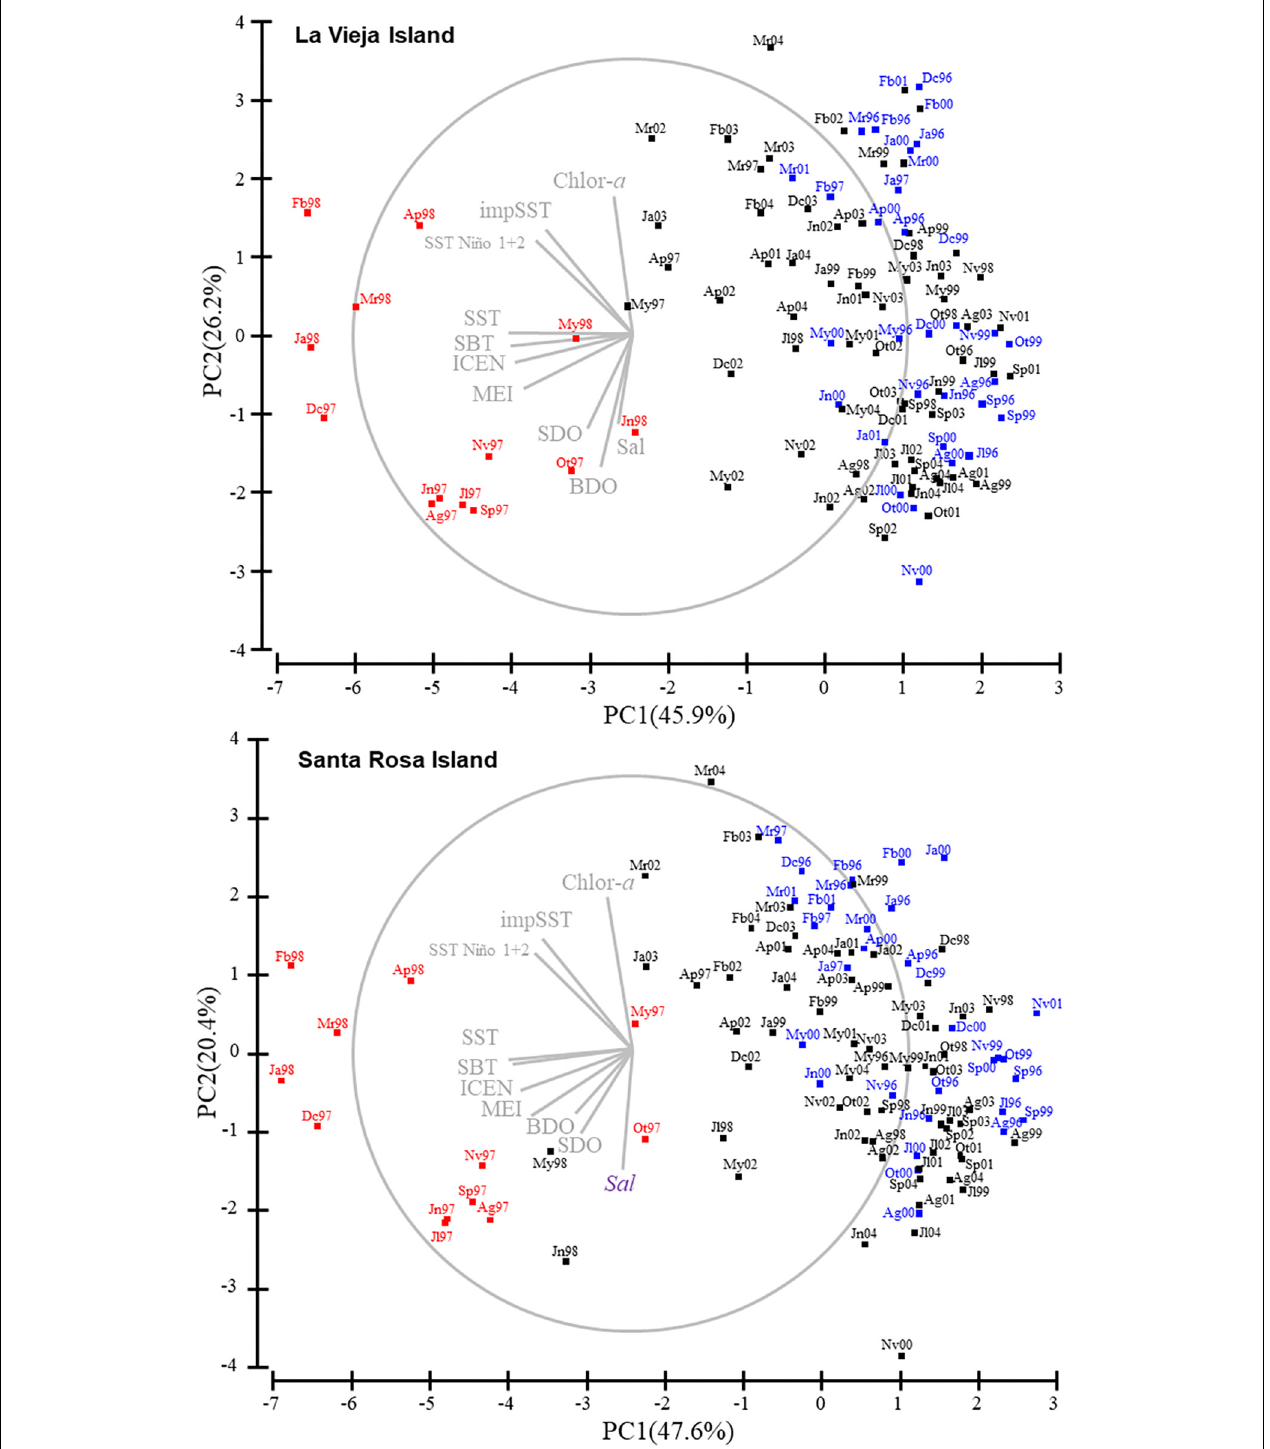
FIGURE 5 | Biplots of Principal Components (PC1 and PC2) after the PCA analysis of regional and local environmental factors at La Vieja Island and Santa Rosa Island and the superimposed vectors (gray lines) of environmental factors (Chlor -a : chlorophyll- a concentration; impSST: sea surface temperature reported by IMARPE; SST Niño 1 + 2: sea surface temperature in the El Niño 1 + 2 Region; SST : in situ sea surface temperature; SBT: sea bottom temperature; ENCI: El Niño-Coastal Index; MEI: Multivariate ENSO Index; SDO: in situ dissolved oxygen; BDO: in situ dissolved oxygen bottom; Sal: salinity). Red and blue text/squares represent periods of EN and LN conditions,